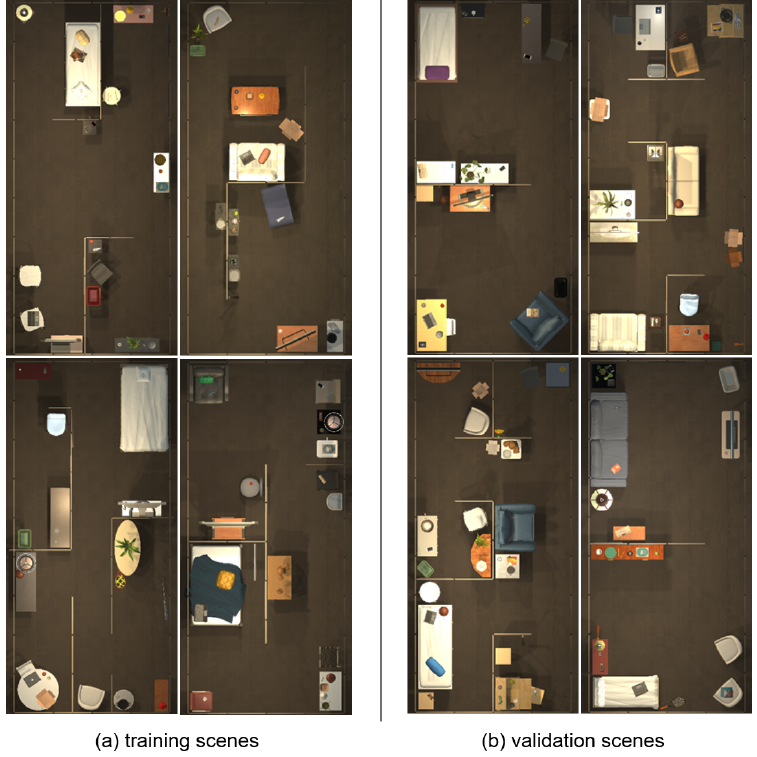
Figure 5. Top view of the selected scenes in the RoboTHOR